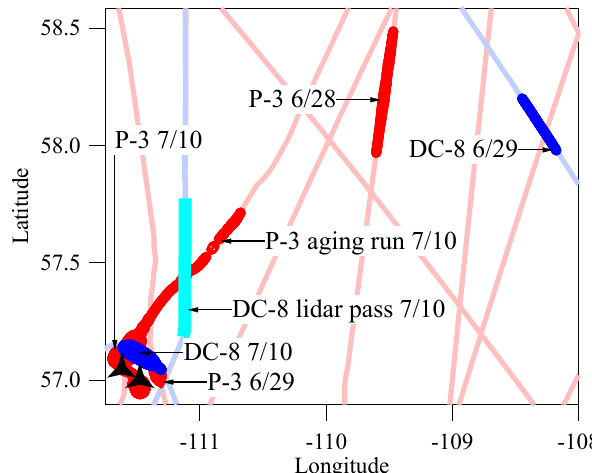
Figure 2. The Suncor facility about 12s before the P-3B encoun- tered the white/gray plume. Stacks emitting darker plumes are visi- ble to the left. The Athabasca River, settling ponds, and mined areas are visible in the background. The image is a still from a windshield- mounted video camera.